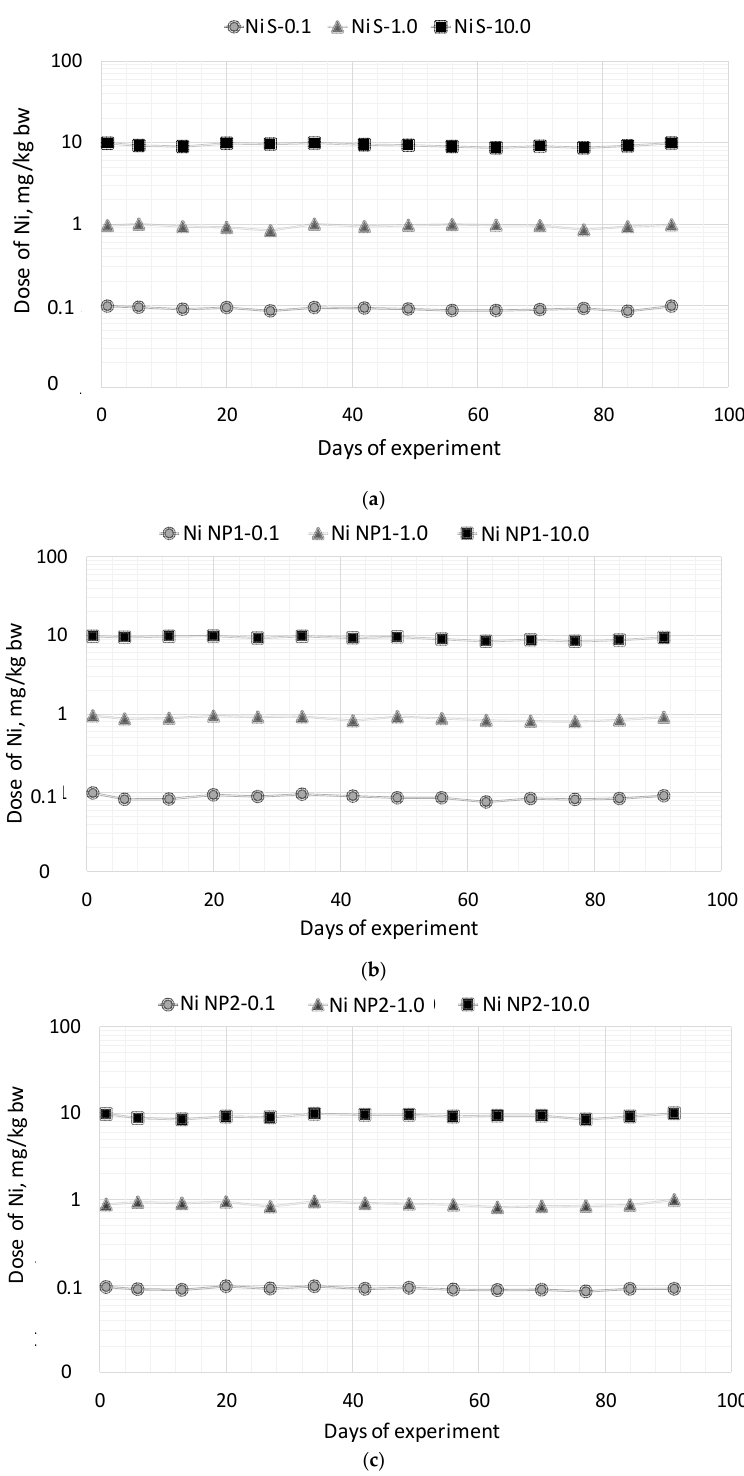
Figure 4. Estimated actual doses of Ni NPs preparations consumed by rats during the 92-day experiment: ( a ) Soluble salt of Ni (Ni S); ( b ) Ni NP1; ( c ) Ni